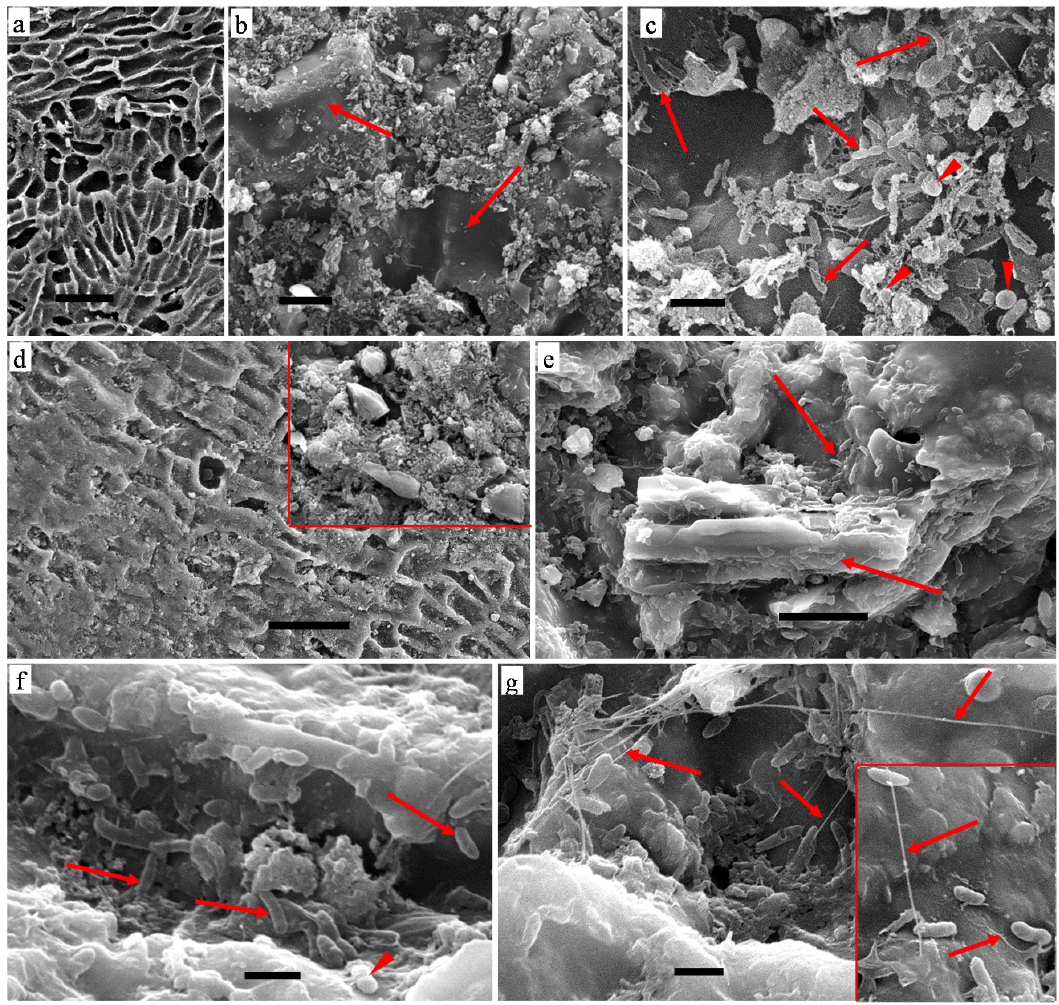
Figure 6. SEM micrographs of palm kernel shell AC biofilms: ( a ) AC before inoculation showing surface micro-structure after steam treatment; ( b , c ) AC-GW inoculation; ( d – g ) AC-FS inoculation. Bars: a,d, 50 μ m; b,e, 10 μ m; c,f,g, 2 μ m.